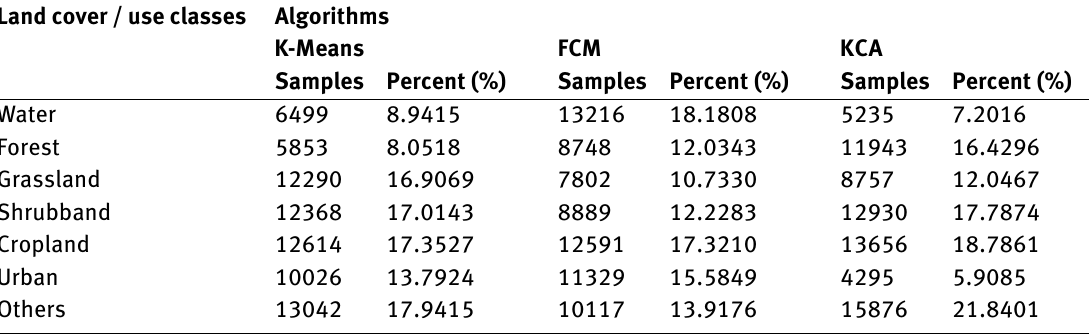
Table 3: Land cover/use classes on chosen image obtained by K-means, FCM and KCA algorithms Land cover / use